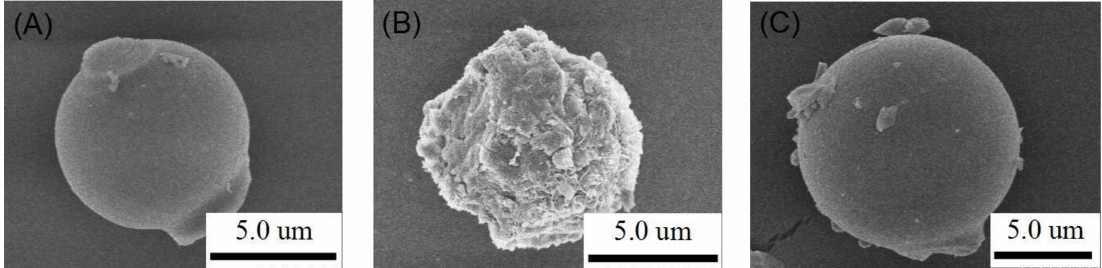
Figure 1. SEM images of the samples: ( A ) spherical SBA-15; ( B ) MOF-1/SBA-15; ( C )